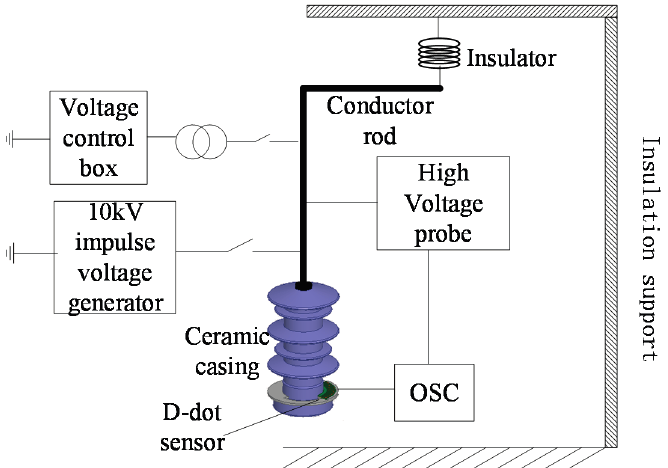
Figure 8. Experimental